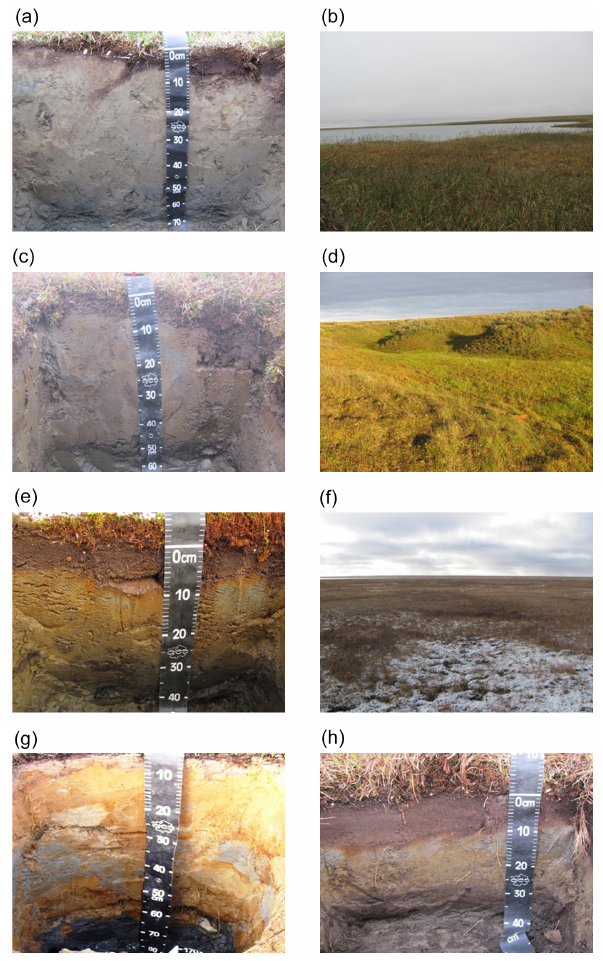
Figure 2. Examples of soils and landscapes analysed in this study. Yavay Cape (a, b) , Gyda Yuribey (c, d) , Enisey Gulf, (e, f) , Beliy Island (g) , Haranasale (h)